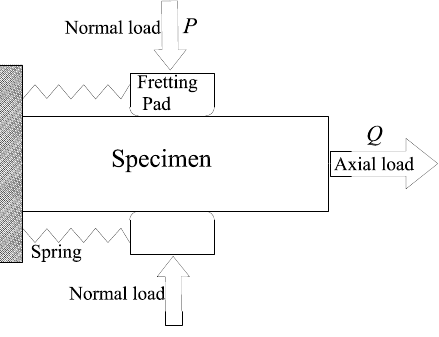
Table 3. Experimental parameters used in fretting fatigue tests.